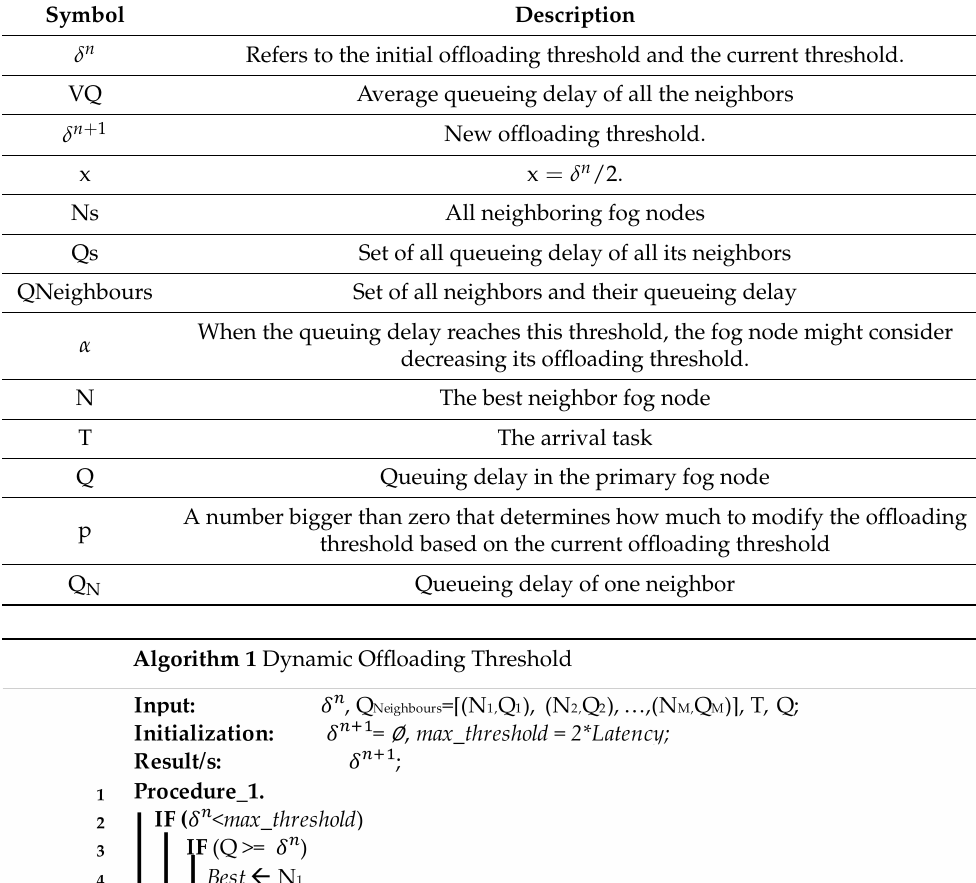
Table 4. Description of Parameters used for Dynamic Threshold